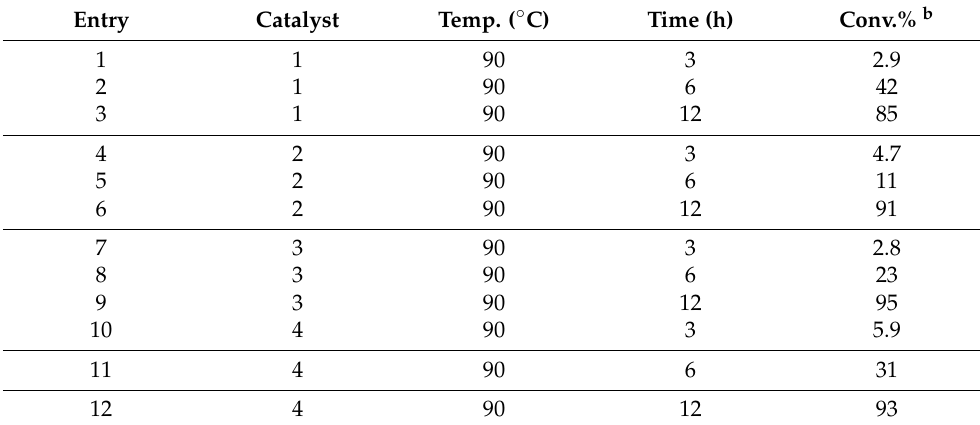
Table 3. Styrene oxide and CO 2 coupling reactions using compounds 1 ~ 4 as catalysts a